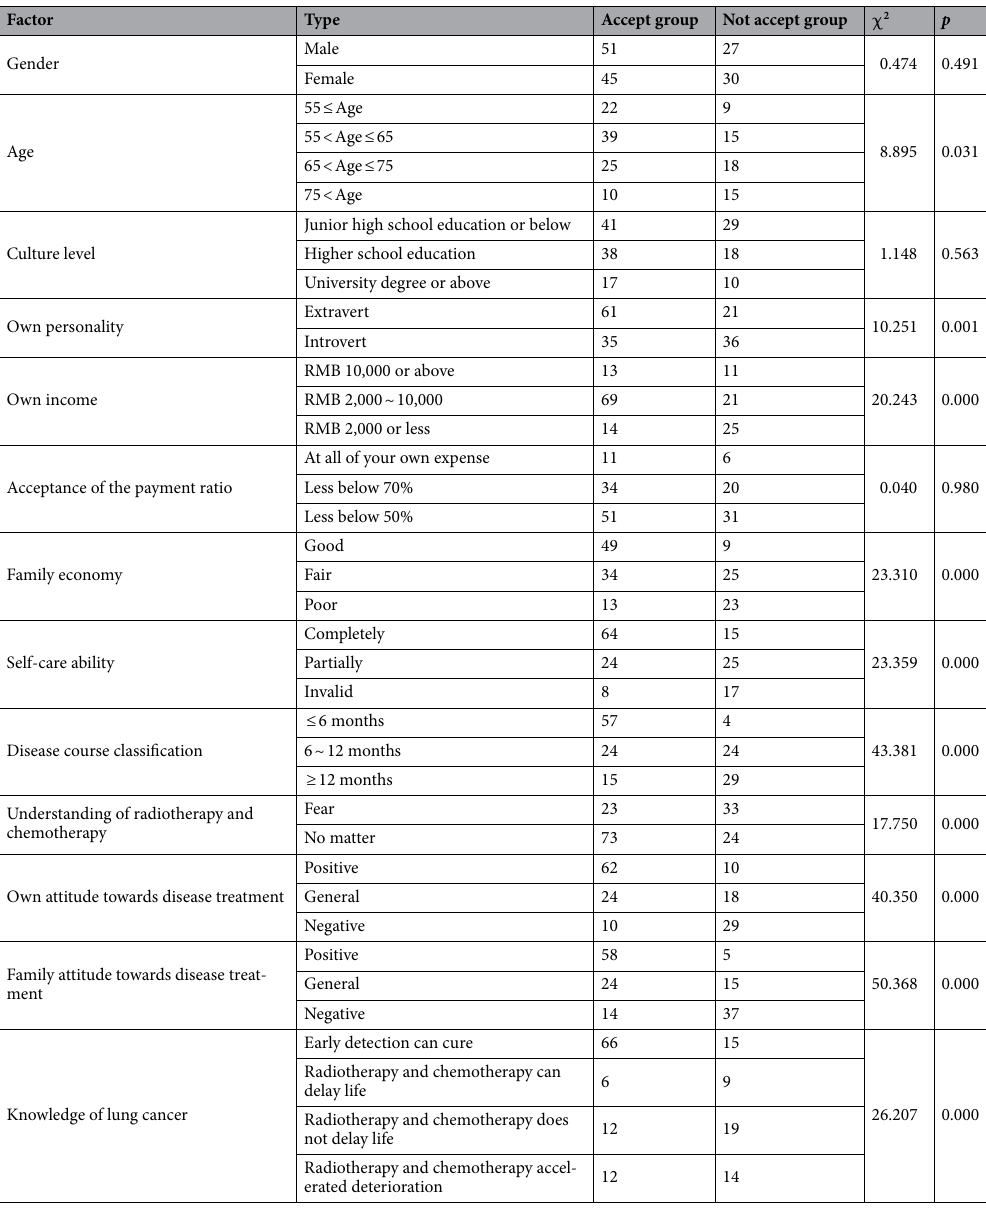
Table 1. Univariate analysis of two groups